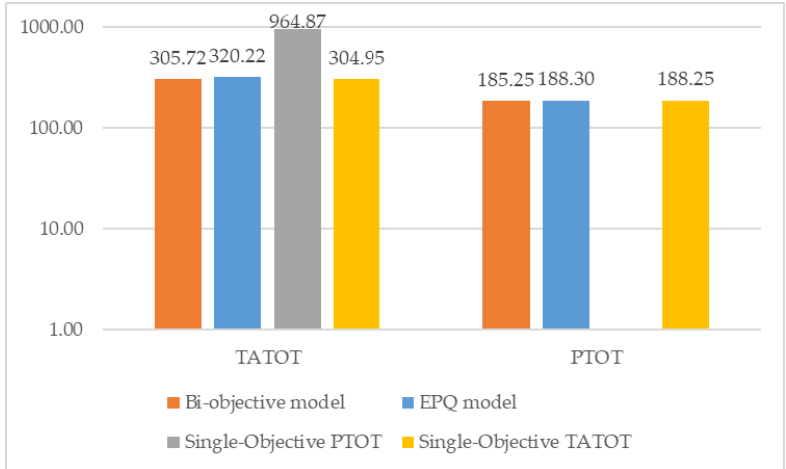
Figure 11. Case study results comparison.